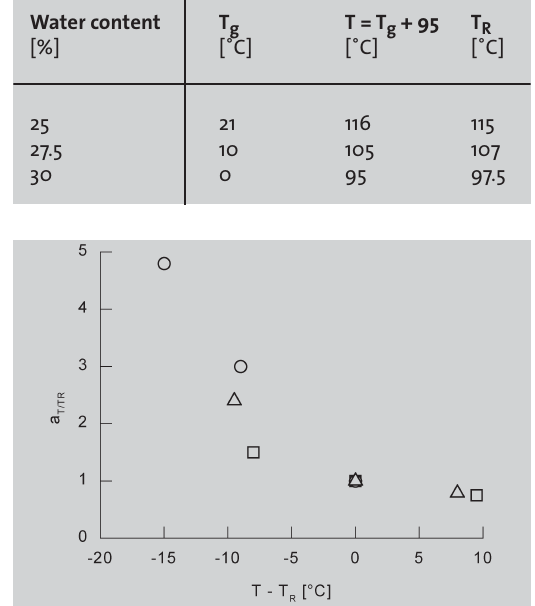
Table 3 (above): Glass temperature, theoretical and practical reference temperature. Figure 8 (below): Shift factors in an iso-free volume condition or different reference temperature (115 (O), 107 ( D ), and 97.5 °C ( (cid:2) )). The corresponding glass transitions are such that the temperature difference toward Tg is constant and equal to 95